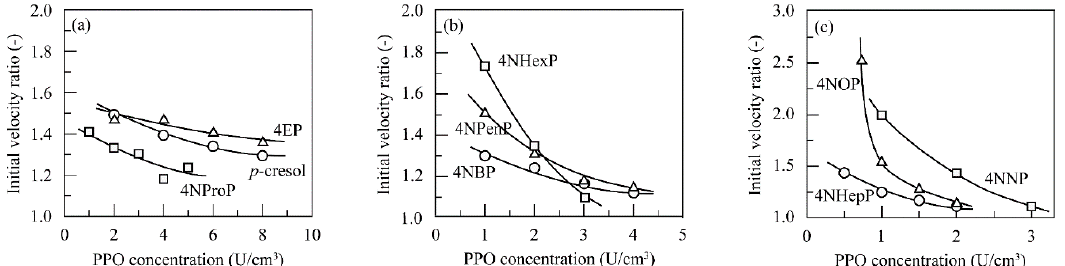
Figure 4. Changes in the initial velocity ratio with the PPO concentration for ( a ) p -cresol ( ○ ), 4EP ( △ ), and 4NProP ( □ ); ( b ) 4NBP ( ○ ), 4NPenP ( △ ), and 4NHexP ( □ ); and ( c ) 4NHepP ( ○ ), 4NOP ( △ ), and 4NNP ( □ ) at pH 7.0 and 40 °C.